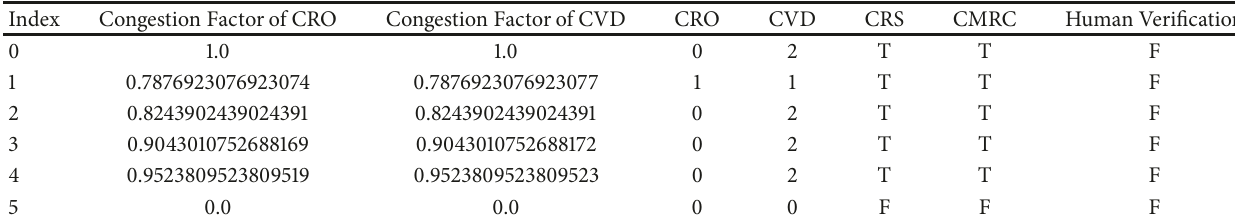
Table 6: Comparison result for road -37932733#6 in Karamay City, China.